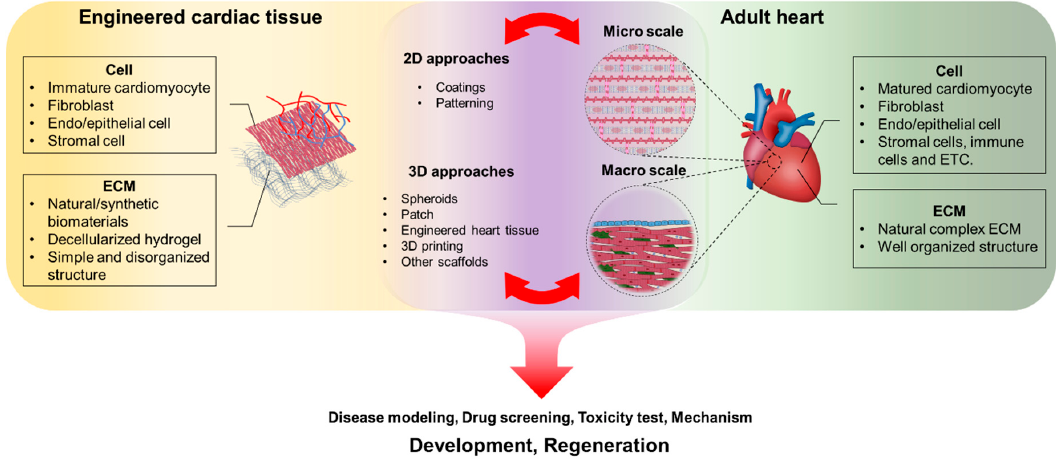
Figure 1. Different strategies to fabricate in vivo-like cardiac tissue by using cells and biomaterials. Figure 1. Di ff erent strategies to fabricate in vivo-like cardiac tissue by using cells and